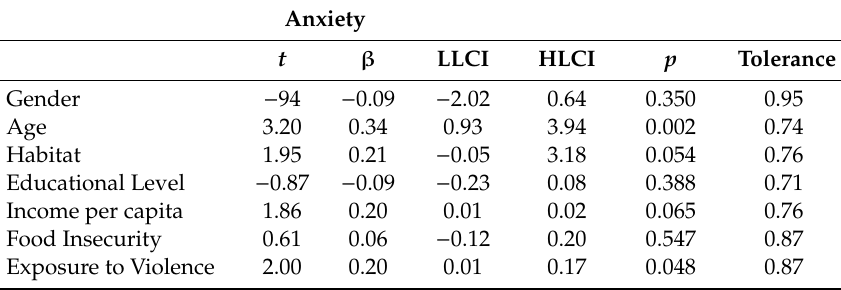
Table 5. Hierarchical regression analysis for anxiety.